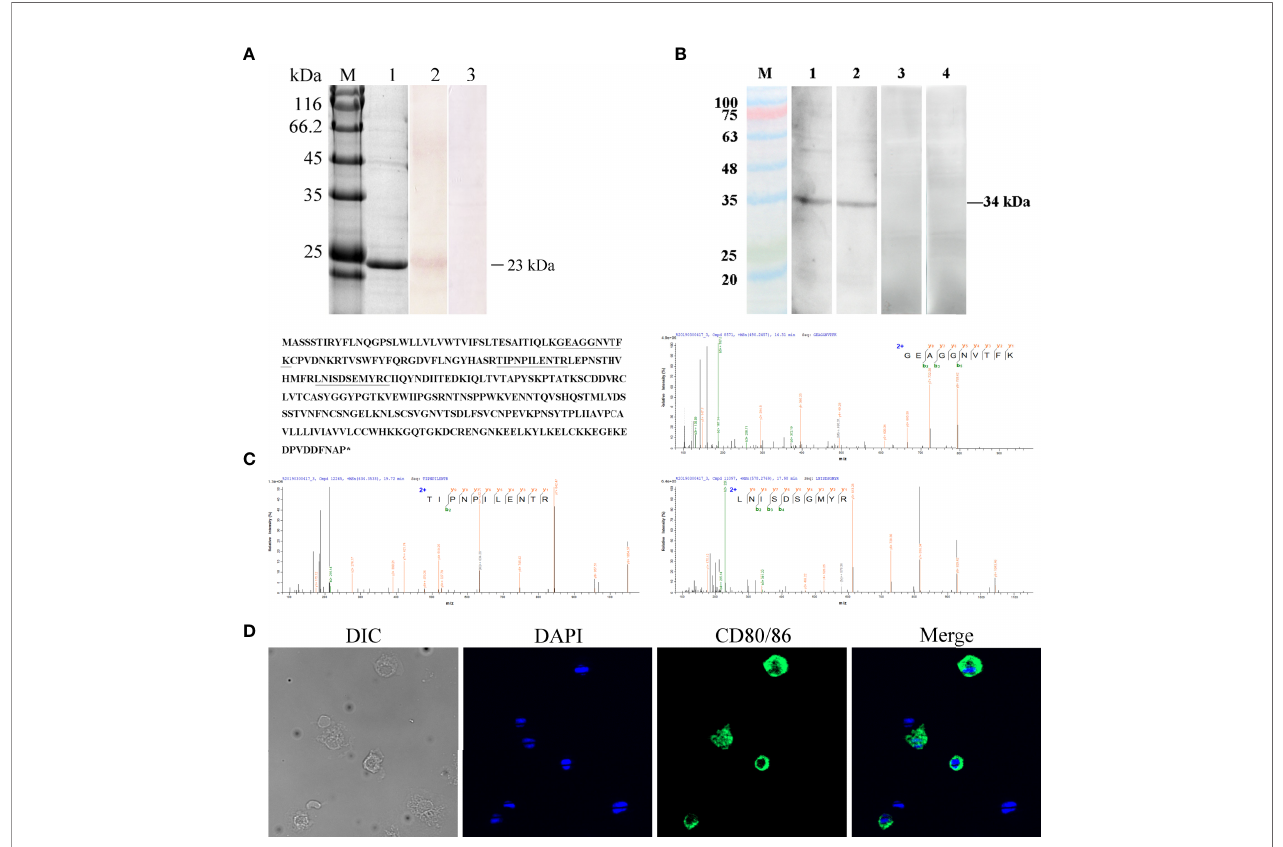
FIGURE 3 | Veri fi cation of the speci fi city of the anti-CD80/86 antibody. (A) SDS-PAGE and Western blotting analysis of rabbit anti-CD80/86 antibody with puri fi ed recombinant CD80/86 protein. Lane M, protein molecular weight marker; Lane 1, puri fi ed recombinant CD80/86 protein; Lane 2, antibodies react to the puri fi ed recombinant protein of CD80/86; Lane 3, puri fi ed recombinant protein incubated with the immunized serum as a negative control. (B) Western blotting analysis of anti- CD80/86 rabbit and mouse polyclonal antibody with the whole-cell protein extracts from PBLs. Lanes 1 and 2, the whole-cell protein extracts from PBLs were incubated with anti-CD80/86 rabbit or mouse polyclonal antibodies, respectively; Lanes 3 and 4, the negative control with unimmunized serum. (C) Mass spectrographic analysis of the immunoreactive band at 34 kDa and the matched peptides are underlined and bolded in the amino acid sequence of CD80/86. Asterisk indicates termination codon. (D) The localization of CD80/86 on PBLs. Nuclei were stained with DAPI, showing blue fl uorescence. Green fl uorescence was distributed on the cell membrane. Scale bar = 10 m